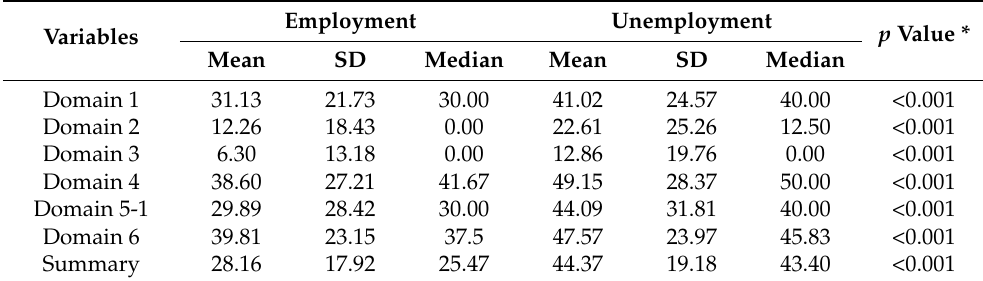
Table 2. Comparison of the scores of 6 domains and summary score of the WHODAS 2.0 between employment and unemployment groups for subjects with Bipolar Disorder ( n = 9886). Variables